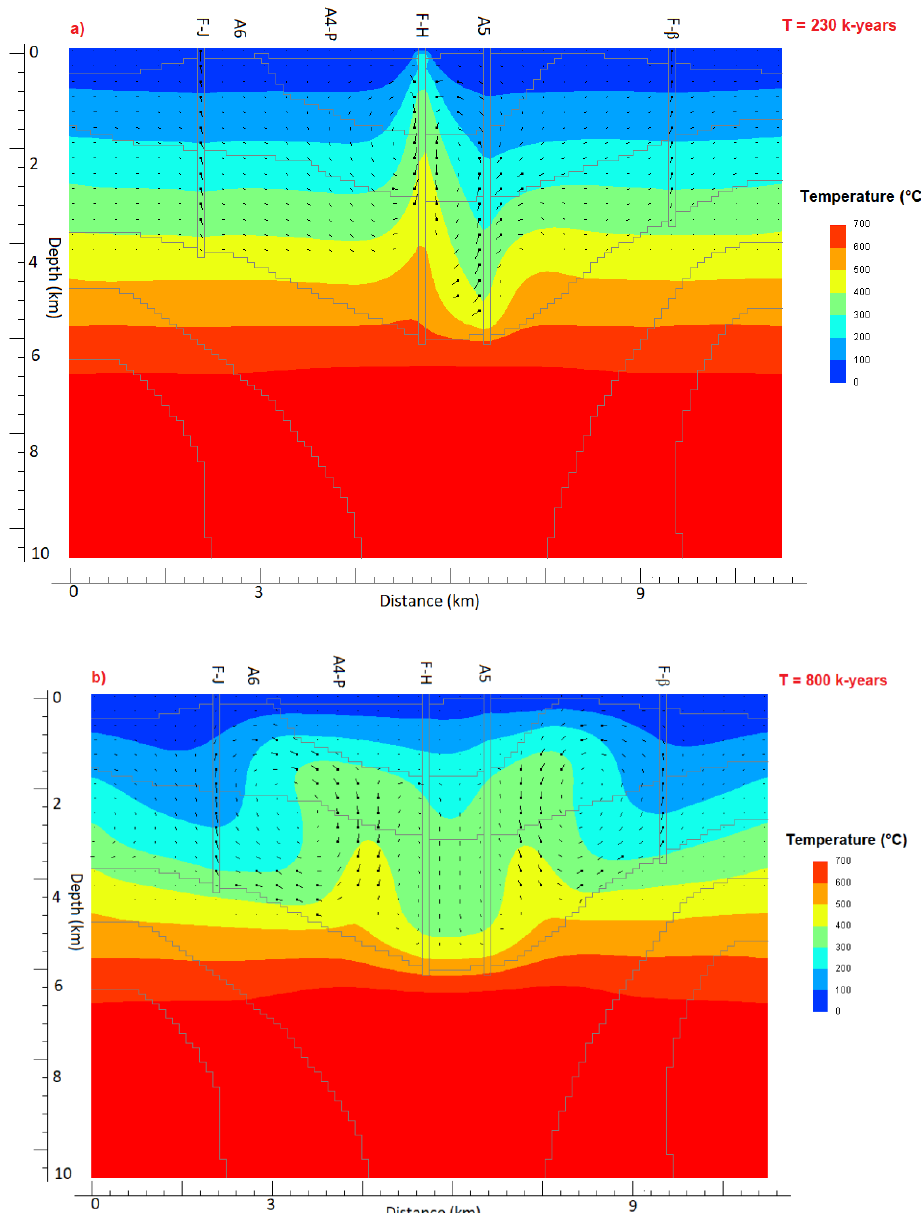
Figure 4. Simulated temperature and flow vectors for ( a ) scenario 3 at time 230,000 years and ( b ) scenario 4 at time 800,000 years. The direction of flow is from the point to the end of straight lines. The length of each line indicates the water vector magnitude, where 1.2 km = 10 −6 g s −1 cm −2 .